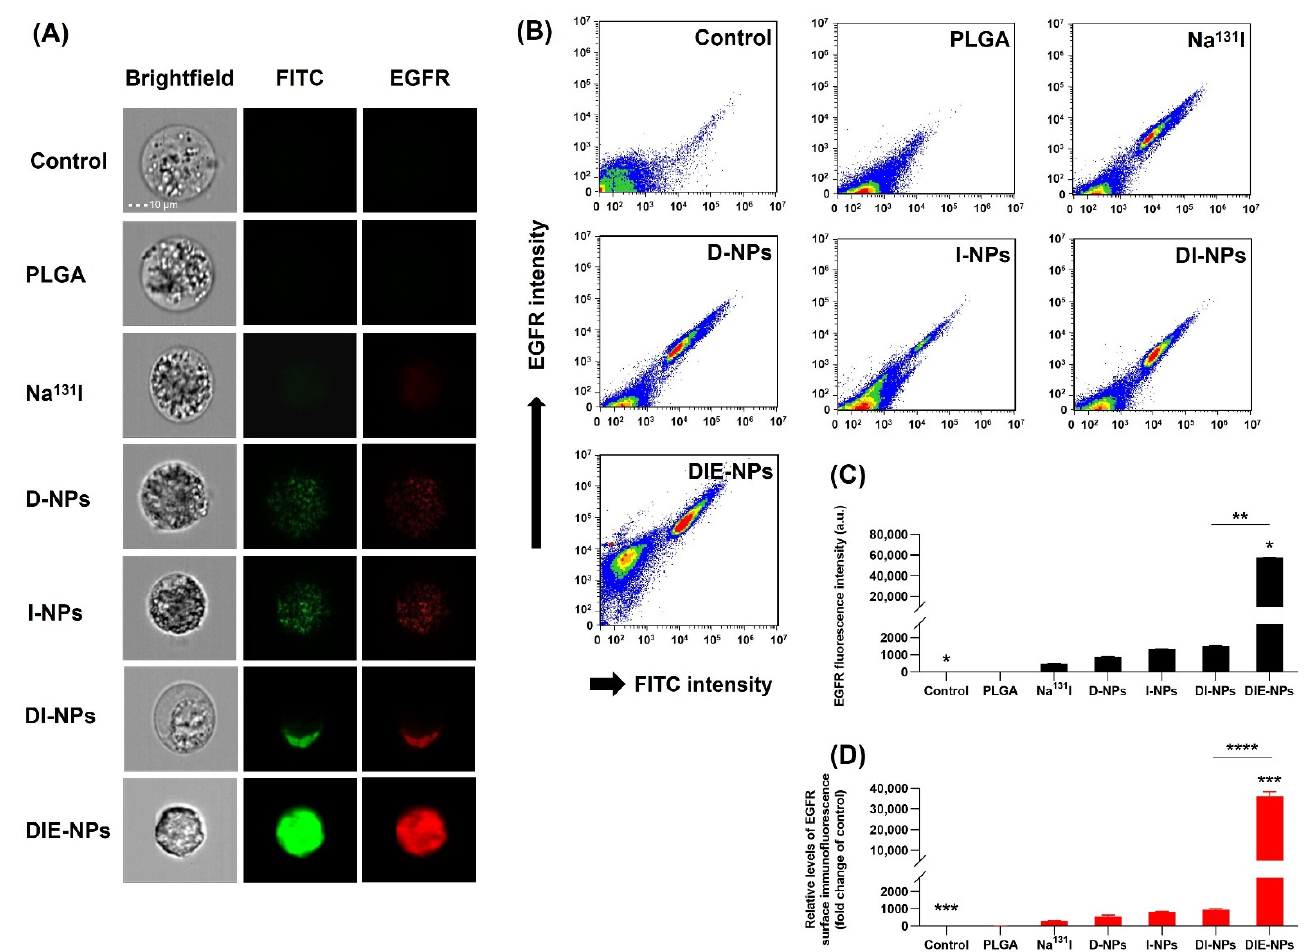
Figure 8. In vitro EGFR antibody cellular binding/uptake targeting efficiency. ( A ) Flow cytometer images of cellular uptake and surface immunofluorescence of MG-63 cells treated with control, PLGA, Na 131 I, D-NPs, I-NPs, DI-NPs and DIE-NPs collected by bright-field (gray channel), Alexa Fluor 647-anti EGFR (red channel) and FITC (green channel). Scale bar = 10 µm. ( B ) Scatter plot of cellular uptake and surface immunofluorescence intensity of MG-63 cells treated with control, PLGA, Na 131 I, D-NPs, I-NPs, DI-NPs and DIE-NPs. ( C ) Quantification of Alexa Fluor 647-anti EGFR (red channel) fluorescence intensities. * denotes significance in fluorescence intensity of EGFR antibody targeting efficiency upon cellular binding/uptake between control and DIE-NPs ( p < 0.05), and ** denotes significance in fluorescence intensity of EGFR antibody targeting efficiency upon cellular binding/uptake between DI-NPs and DIE-NPs ( p < 0.05). ( D ) Relative levels of Alexa Fluor 647-anti EGFR surface immunofluorescence (fold change of control). *** denotes significance in relative levels of Alexa Fluor 647-anti EGFR surface immunofluorescence (fold change of control) between control and DIE-NPs ( p < 0.05). **** denotes the relative significance of Alexa Fluor 647-anti EGFR surface immunofluorescence (fold change of control) between DI-NPs and DIE-NPs ( p < 0.05). Data are given as mean ± standard deviation ( n =